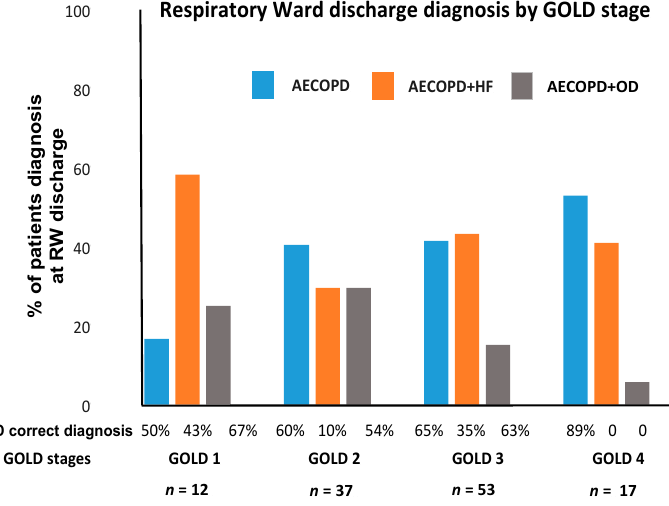
Figure 2. Prevalence of AECOPD type by RW diagnosis in GOLD stages and coincidence with ED diagnosis. Percent of patients diagnosed at the RW of AECOPD, AECOPD and HF, AECOPD and OD in the di ff erent GOLD stages. Bottom of the figure shows the percentage of correct diagnosis at the ED for each RW diagnosis.